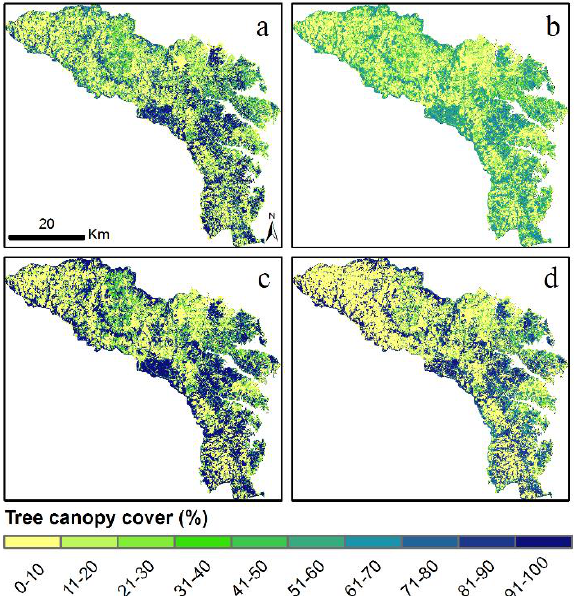
Figure 2. Maps of percent tree canopy cover in Howard County and Anne Arundel County, Maryland. a. Reference data derived from airborne Lidar. b. Landsat-based tree cover DS1 (Sexton et al. 2013). c. Landsat-based tree cover DS2 (Hansen et al. 2013). d. Landsat-based tree cover DS3 (Homer et al. 2004).